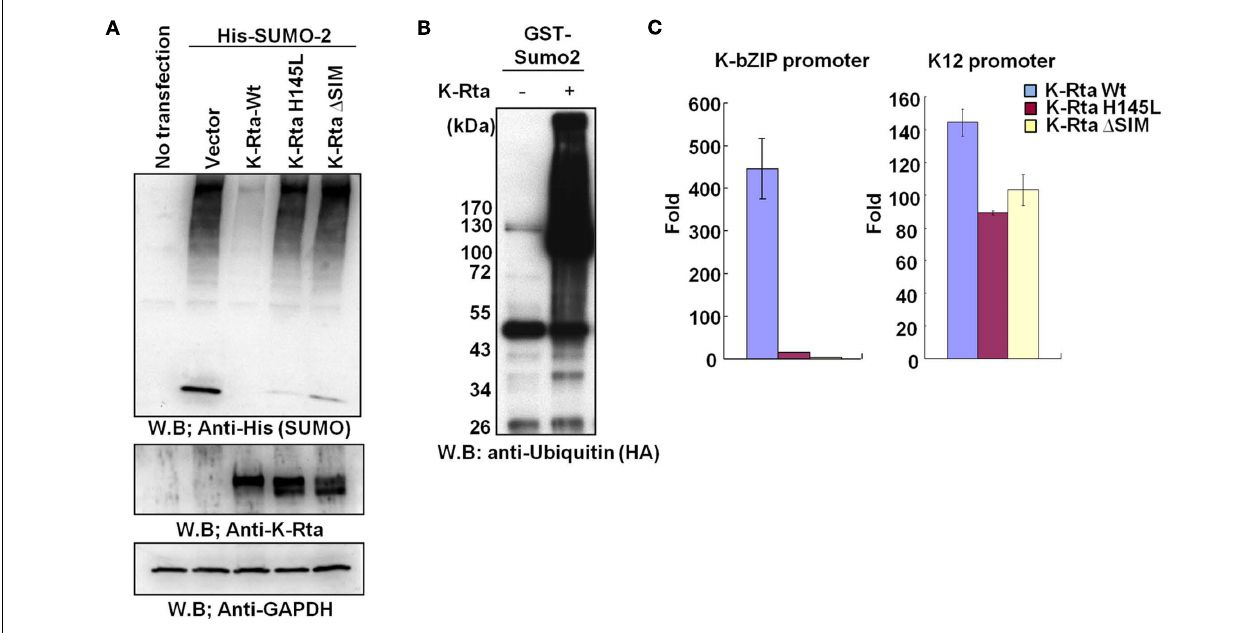
products were probed by immunoblotting. In the presence of K-Rta, GST–SUMO was conjugated with ubiquitin. (C) KSHV promoter reporter assay. 293T cells were co-transfected with K-Rta wt or mutant and the indicated KSHV promoter luciferase reporter. Forty eight hour later cellular lysates were prepared and assayed for luciferase activity.Values represent the mean fold induction (mean ± SD, n = 3 determinations) relative to the value derived from reporter + empty vector set as = 1 (K-Rta wt, blue; H145L, red; Δ SIM,